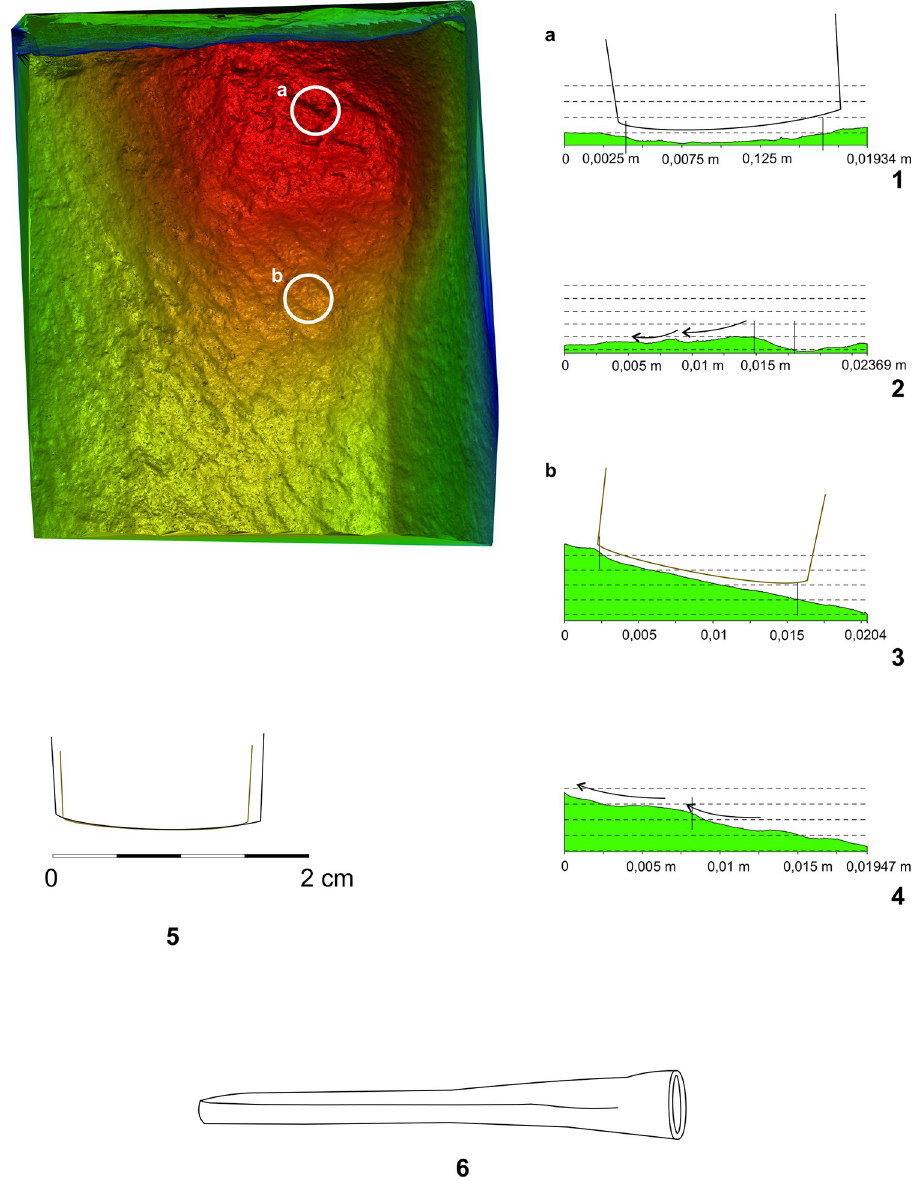
Fig 12. Fragment of a leg of the Statue 2 from Glauberg. 1–2 transverse and longitudinal sections of the identified trace (a); 3–4 transverse and longitudinal sections of the identified trace (b); 5 reconstruction of the identified blade of the tool as derived from individual traces; 6 hypothetical reconstruction of relavant tool (author: M. Cihla and F. R. Va´clavı´k).